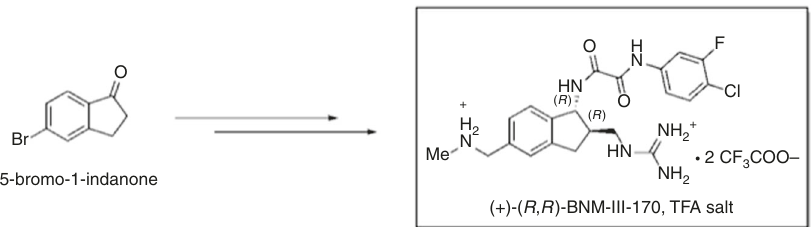
Fig. 1 Structure of the CD4mc, BNM-III-170, used in this study. The tri fl uoroacetate (TFA) salt of BNM-III-170 was synthesized from 5-bromo-1-indanone following the procedures in ref.